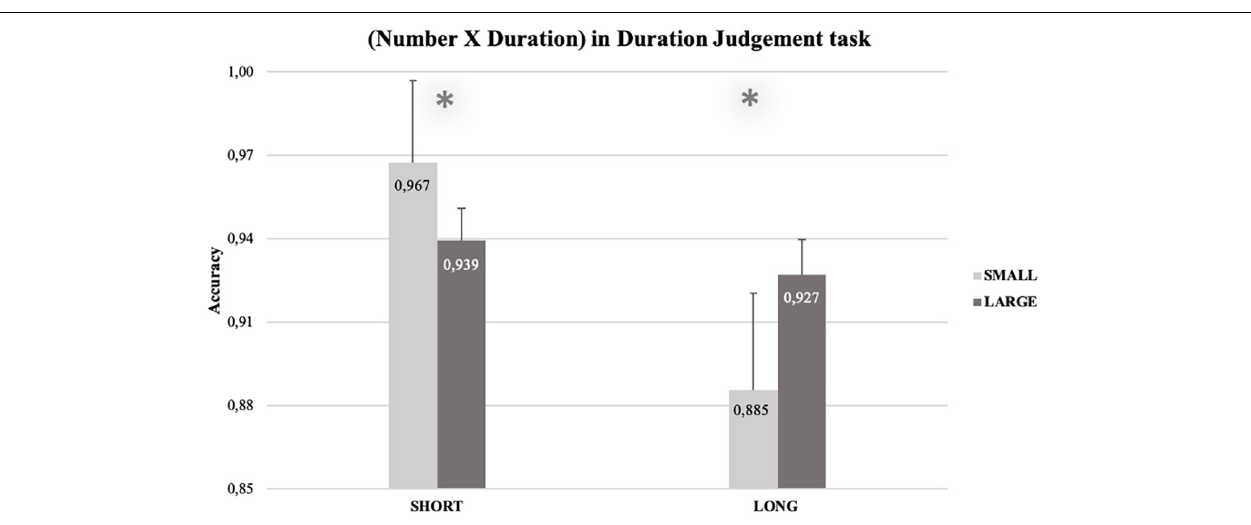
FIGURE 4 | Percentage of correct answers for the duration judgment task, as a function of Duration (short vs. long) and Number (small vs. large). Accuracy for short durations was higher when numbers were small ( M = 0.967, SEM = 0.015) than when they were large ( M = 0.939, SEM = 0.006). Similarly, accuracy for long durations was higher when numbers were large ( M = 0.927, SEM = 0.006) than when they were small ( M = 0.885, SEM = 0.018). The error bars indicate the confidence intervals (95%), corrected for within-subjects designs (O’Brien and Cousineau, 2014; single